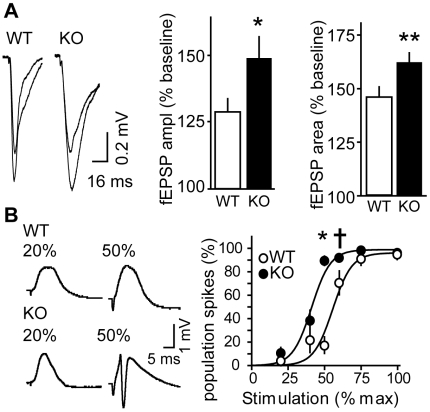
Increased Mg2+-sensitive post-synaptic potential and reduced threshold for epileptiform activity after conditional loss of Cdk5.
A, Representative traces and quantitation of fEPSP amplitude (n = 12) and area (n = 6) in the stratum radiatum relative to baseline following Mg2+ wash-out. B, Representative traces and quantitation showing reduced threshold for population spikes in the stratum pyramidale of KO slices after stimulation in the hippocampal SC/CA1 pathway in Mg2+-free conditions. Quantitation shows % of slices displaying population spikes at indicated stimulation intensities (% of maximum). Recordings were performed 4–6 weeks post-KO. n = 16–18; ANOVA revealed a main effect of genotype (F1,217 = 36.16, p<0.0001), stimulation (F6,217 = 115.41, p<0.0001) and interaction between genotype and stimulation (F6,217 = 11.76, p<0.0001). **P<0.05, *P<0.01, †P = 0.067 vs. WT, post hoc t-test. Data represent mean±s.e.m.